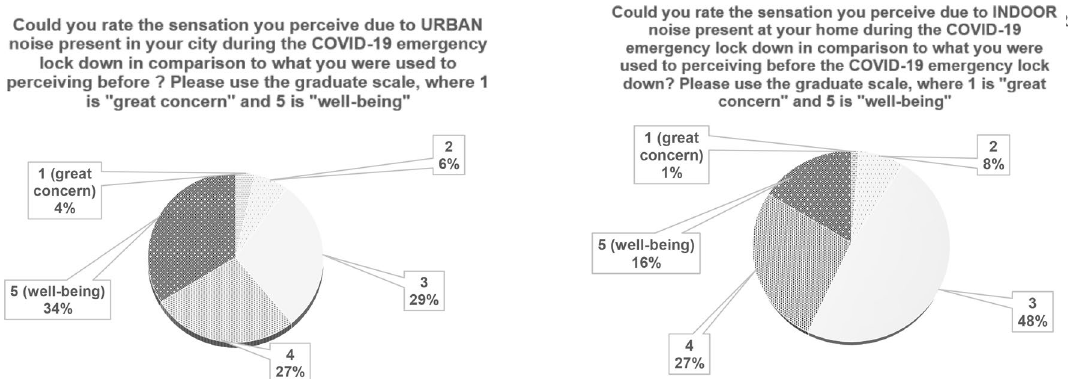
Figure 7. Italian results: comparison between outdoor and indoor noise variation